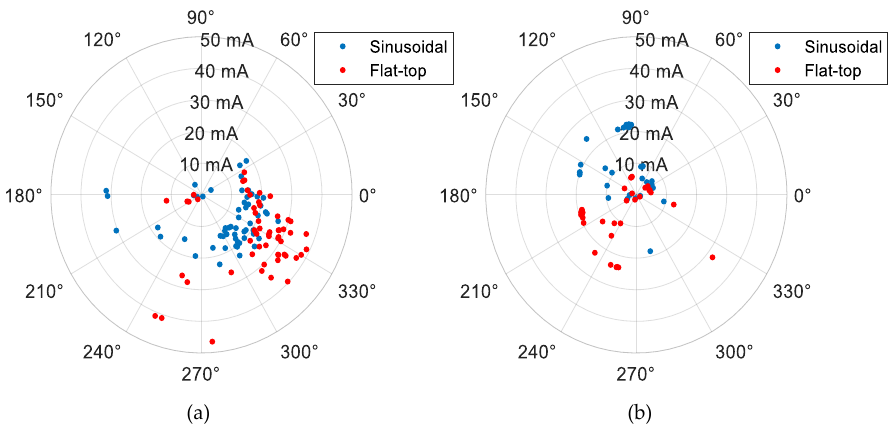
Figure A5. Ninth harmonic current emission of the selected lamps under the two types of supply voltage: ( a ) CFL and ( b ) LED lamps.